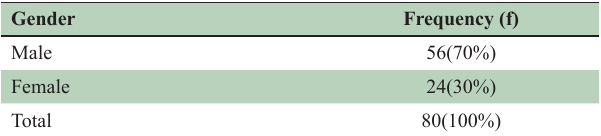
Table-I: Distribution of respondents according to Gender.